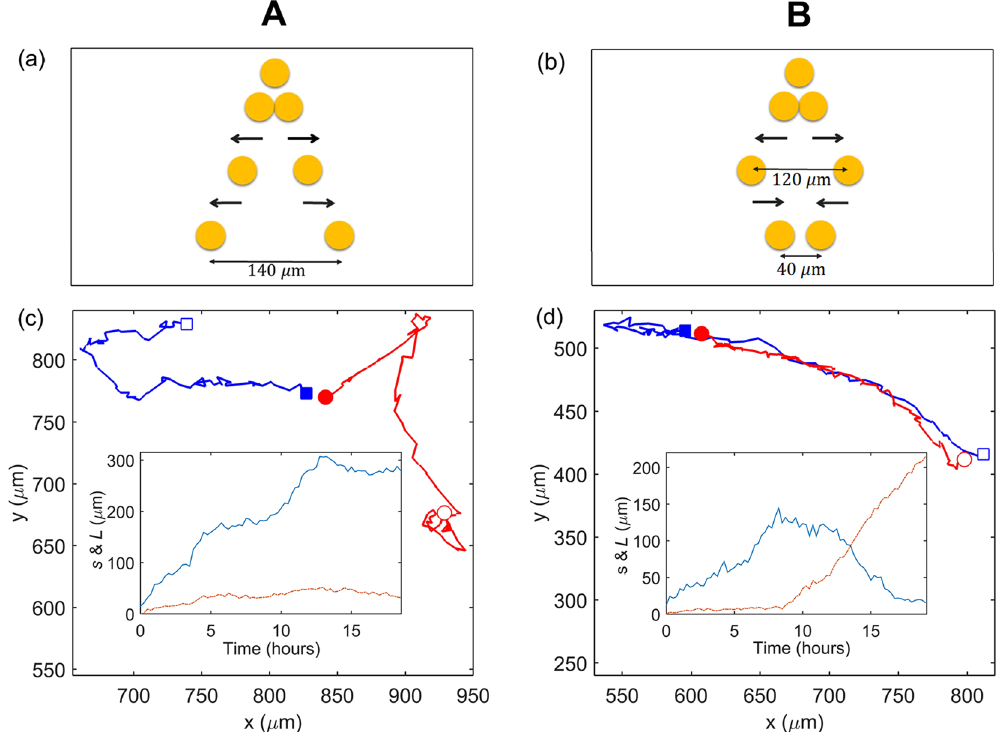
Figure 5. ( a ) Typical behaviour of a Type A pair, in which the cells appear to repel continually over time, and ( b ) of a Type B pair, where the cells first appear to repel and then attract each other. ( c ) The trajectories of the cells in a representative Type A pair (originating from Cell 14 in Fig. 1a), with the initial (final) centroid positions marked with filled (open) symbols. Inset: the separation between the cells, s (blue line) and the displacement of the pair’s pair centroid position (orange line). ( d ) As in ( c ), but for a representative Type B pair (originating from Cell 13 in Fig. 1a). The cells are shown as circles or squares only for illustrative